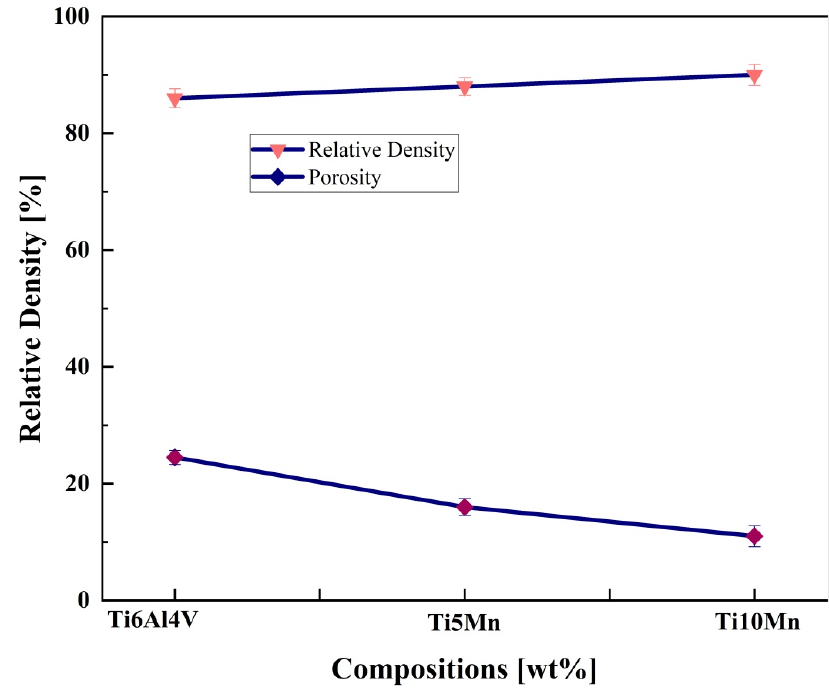
Figure 3. The relative density and porosity of the titanium-based alloys.